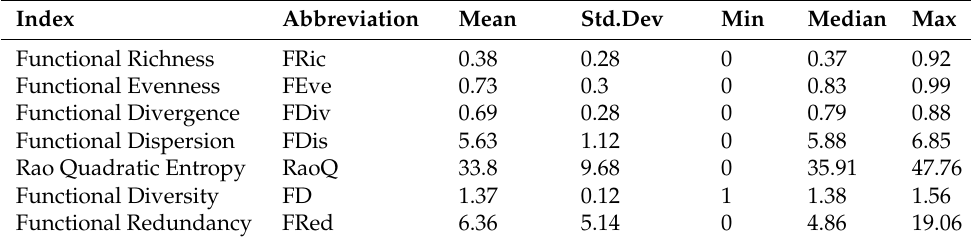
Table 3. Functional diversity indices used in the